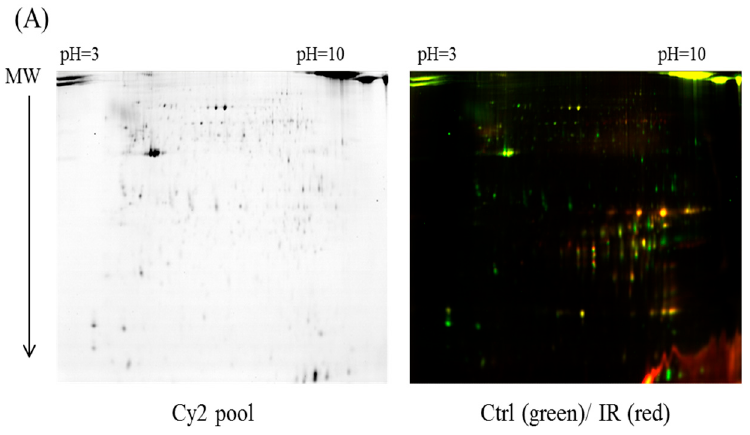
Figure 4. Cont. Figure 4. Cont.